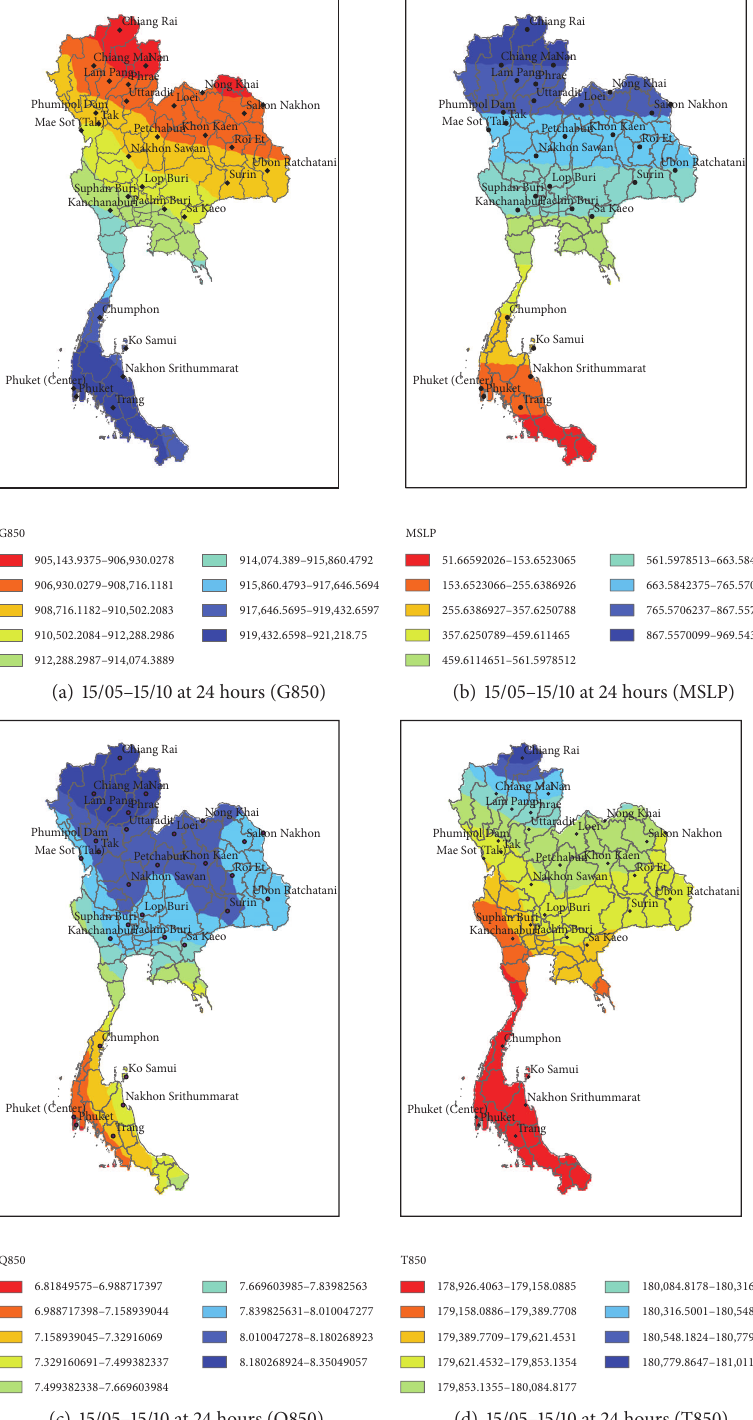
Figure 8: The 850 hPa geopotential height (G850), mean sea level pressure (MSLP), 850 hPa moisture (Q850), and 850 hPa temperature (T850) from CFSv2 during 15 May to 15 October 2010 at the 30 stations in